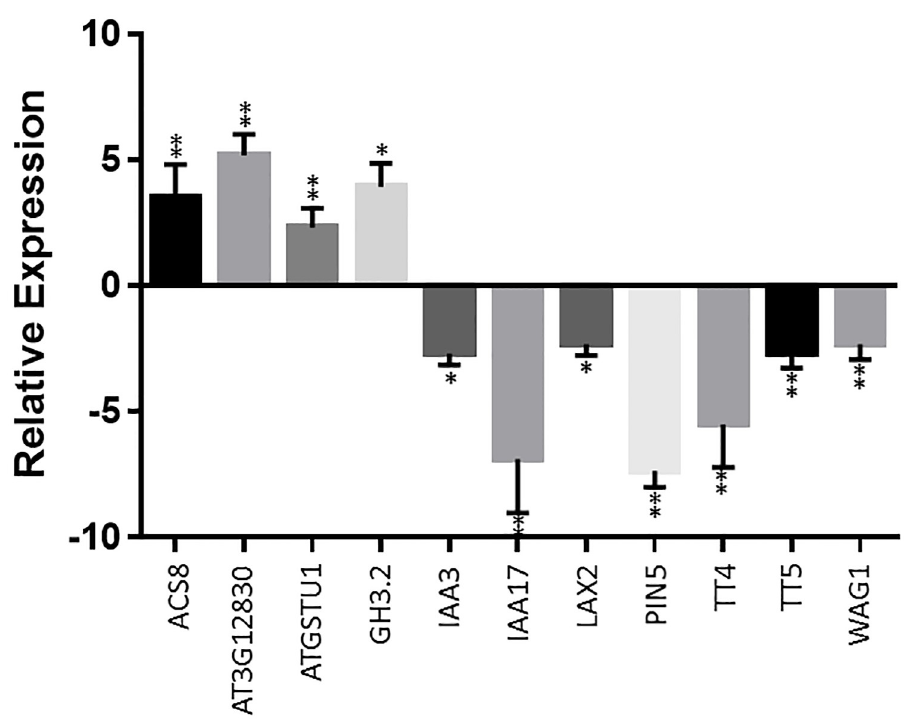
Fig 1. The expression pattern of auxin signal and auxin transport related genes altered by melatonin treatment. qRT-PCR was performed to assess the relative transcript levels of auxin related genes identified by RNA-seq. Samples were treated with or without 300 μ M melatonin for 16 hours. The transcript levels are expressed relative to that of Arabidopsis EF1 gene in each sample, and values are mean ± SD (n = 4). Student t-test was used for P-value calculation. � P < 0.05, �� P <